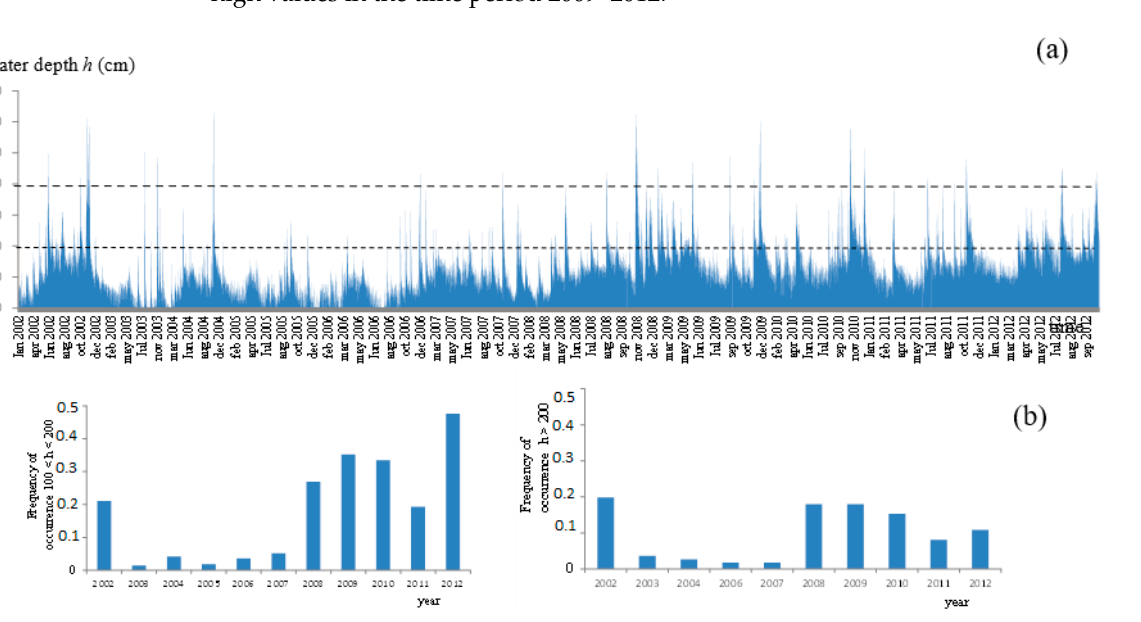
Figure 3. ( a ) recorded data during time period 2002–2012 at Villuzza gauging station; ( b ) frequency of occurrence of events with water depth 100 cm < h < 200 cm and of events with water depth h > 200